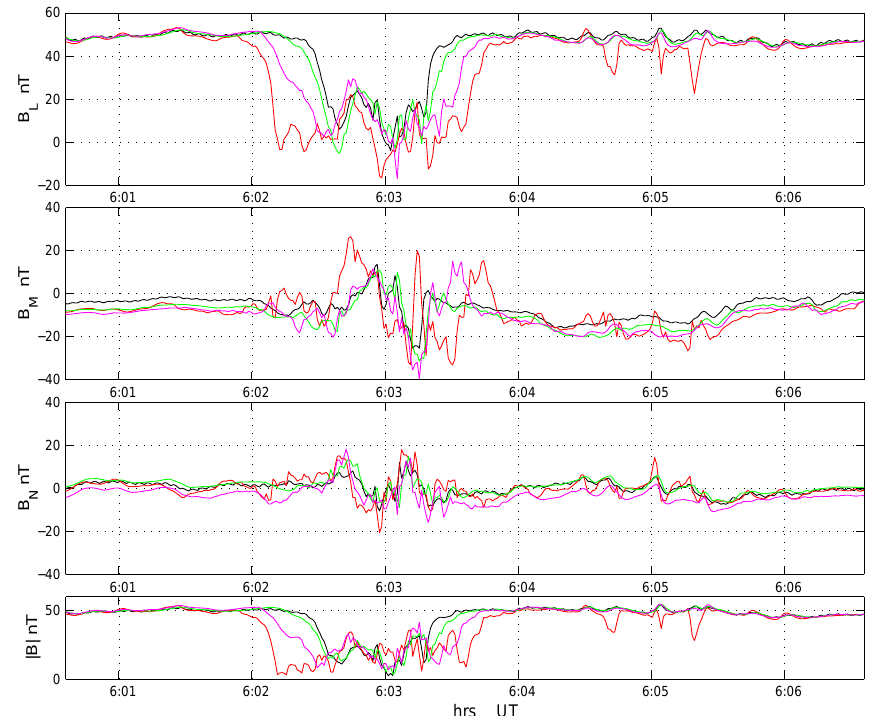
Fig. 6. As for Fig. 4a, but for crossing